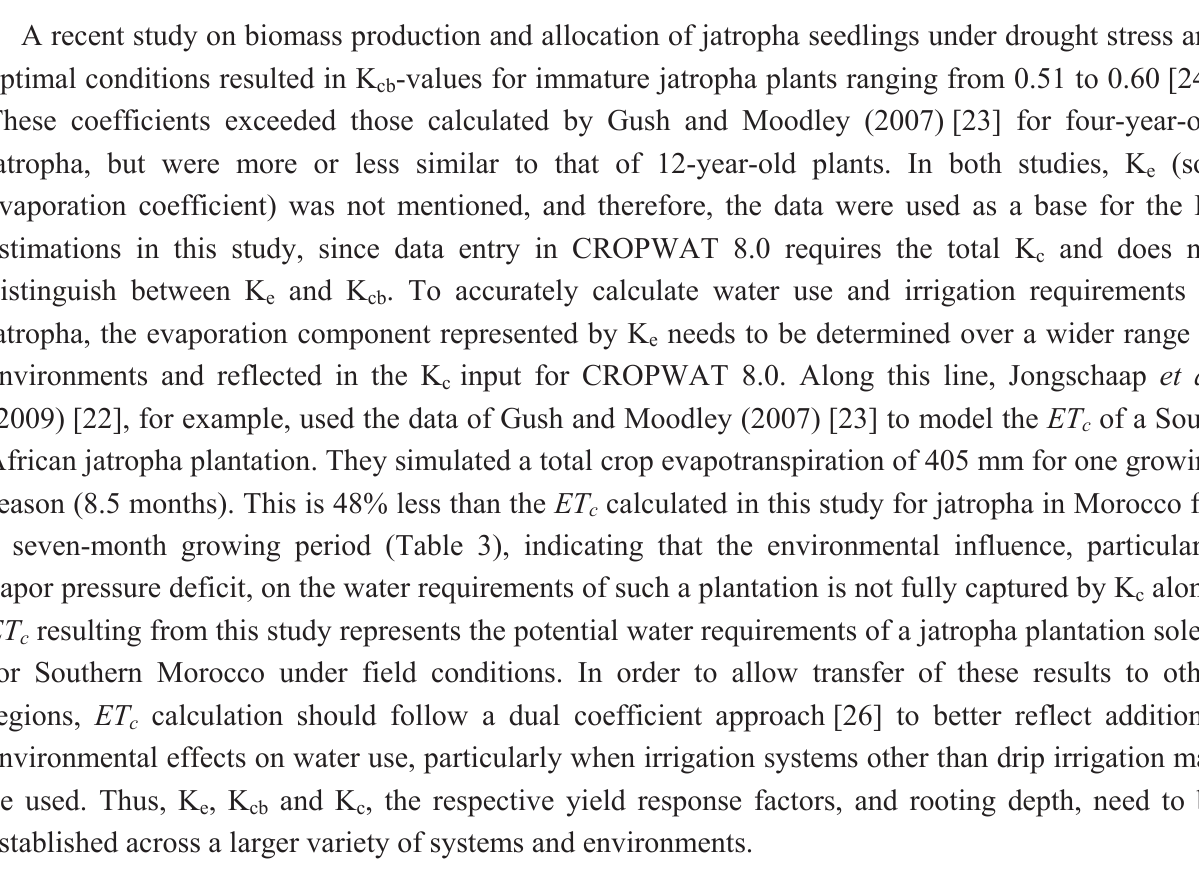
Table 3. N, P, K, Na + and K + inputs (kg ha (cid:237)(cid:20) ) from effluent irrigation at different leaching fractions ( LF ) corresponding to both crop evapotranspiration ( ET , mm) in mm per growing season irrigation requirement ( IR g